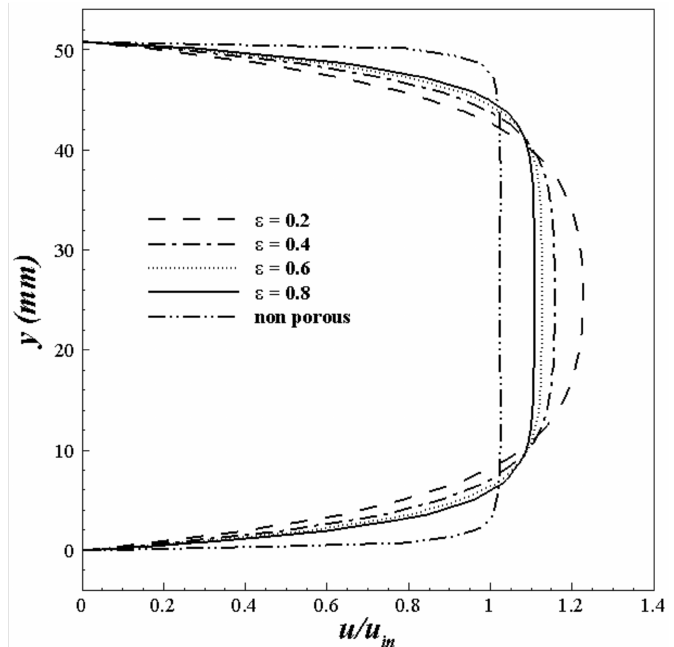
Figure 6. The variation in velocity profile at a permeability of 5 × 10 − 6 m 2 and different porosity coefficients for non-porous and porous collectors, where u in = 2 m/s and L = 500